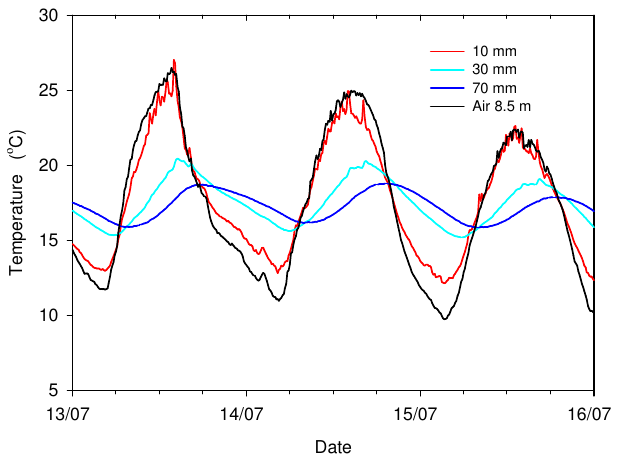
Fig. 2. The estimated trunk surface temperature at different heights along the trunk of a pine tree as well as the temperature of the branches and of the